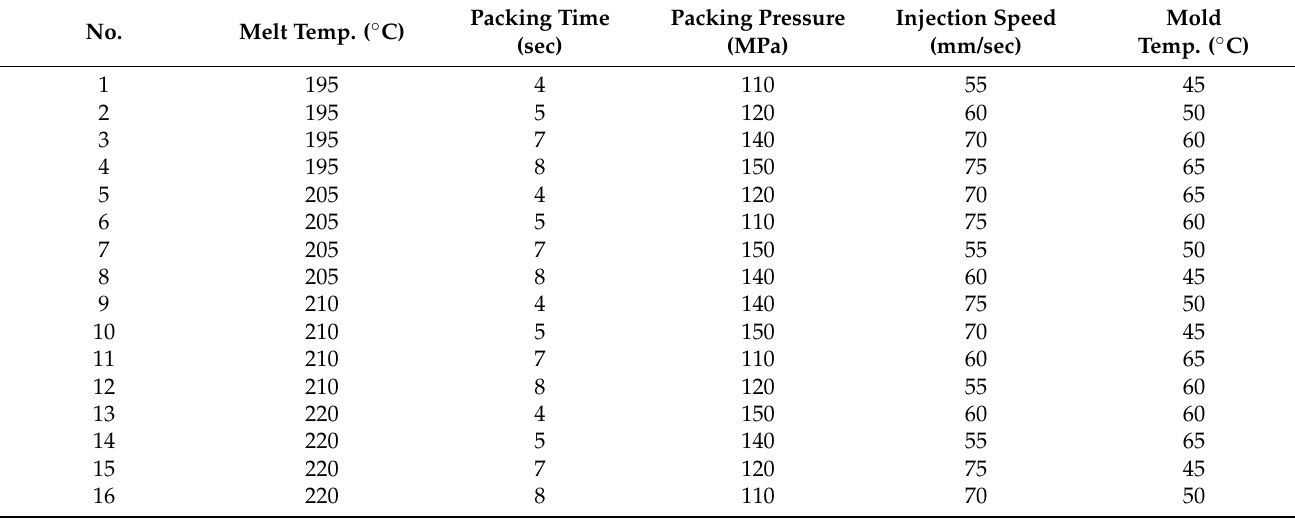
Table 5. CAE verification data for square tablet